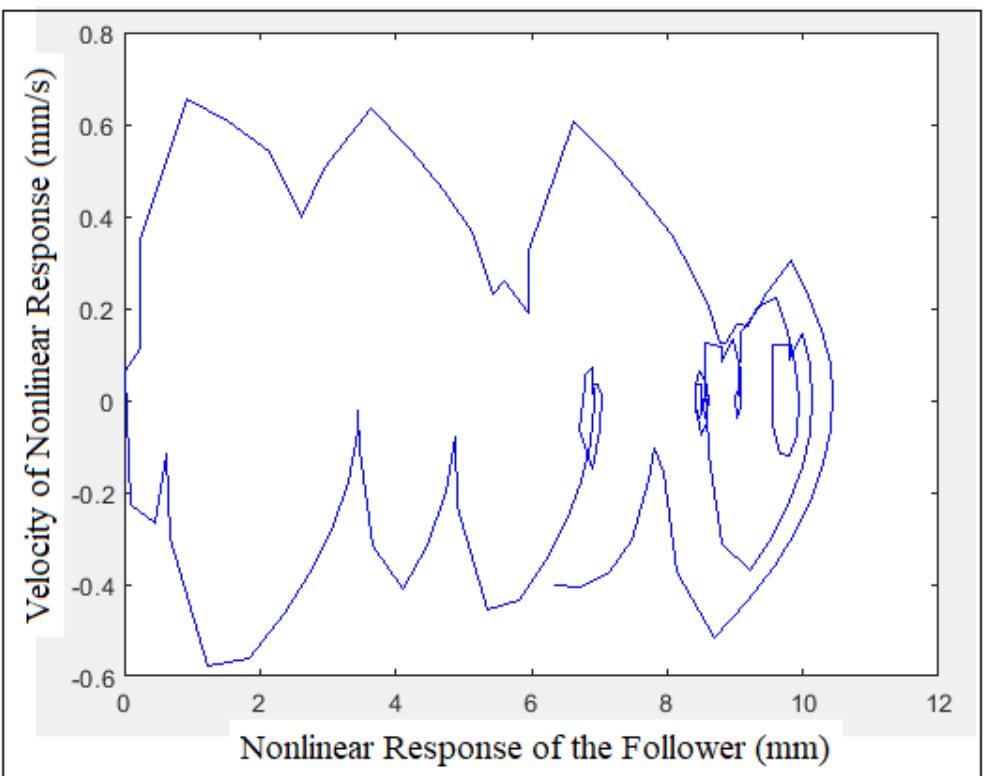
Figure 24. Phase-plane diagram at (N = 200 rpm) when the follower offsets to the left at (O = 10 mm) without follower guide’s